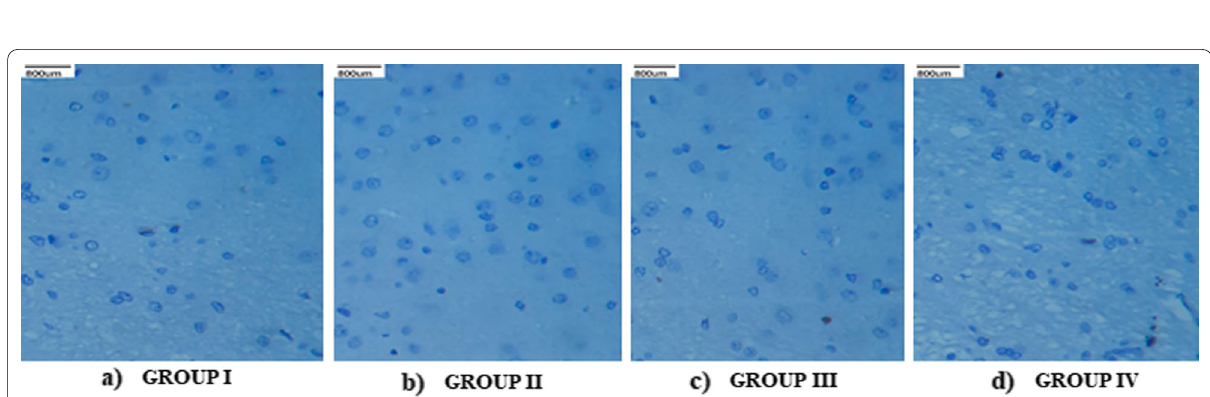
Fig. 8 Representative photomicrographs of Caspase -3 expression on dorsal hippocampus of rats received ICV infusions of PBS or PPA for 7 days. a